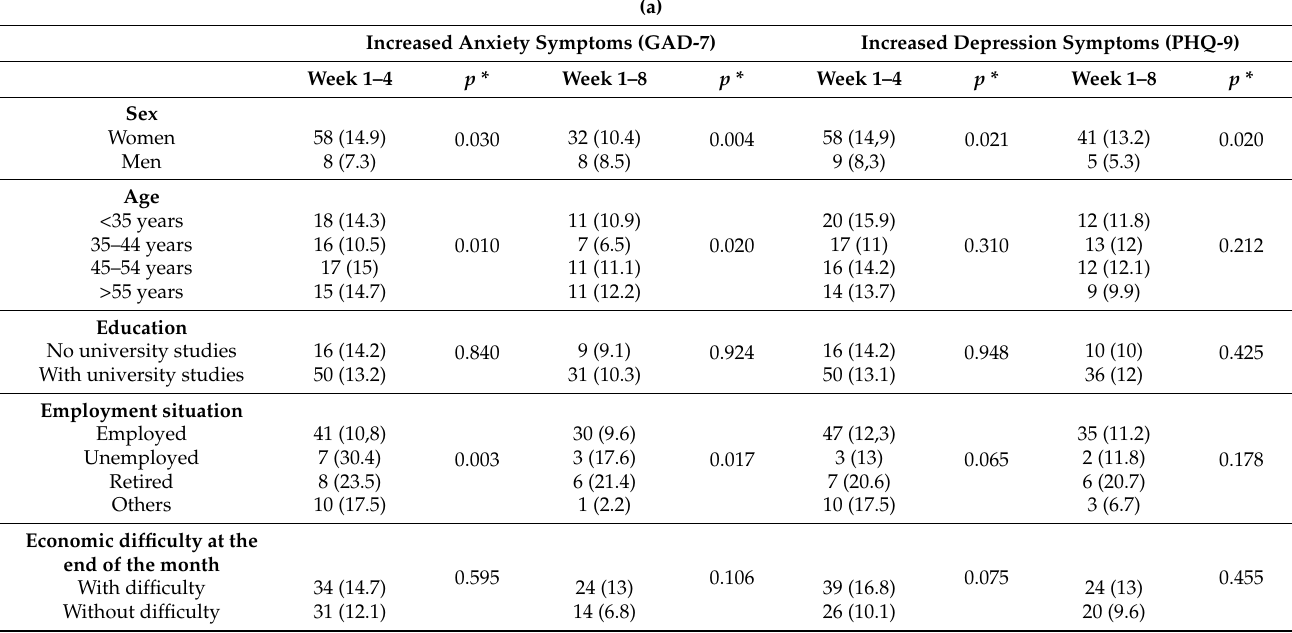
Table 4. Relationship between the sociodemographic variables and worsening psychological wellbeing indicators over the eight-week